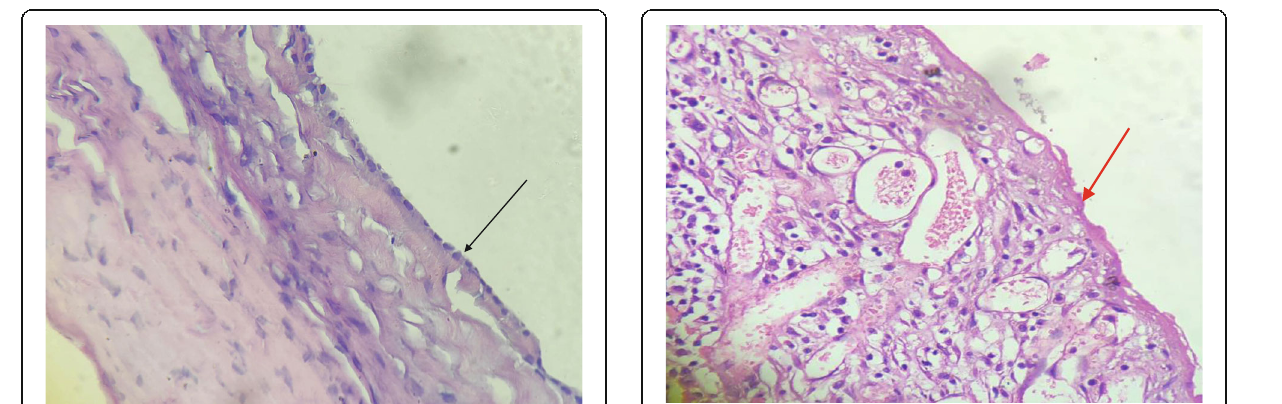
photomicrograph of a cyst wall lined by flattened epithelial cells (black arrow) resting on fibrocollagenous stroma which is consistent with a diagnosis of Mesenteric Cyst